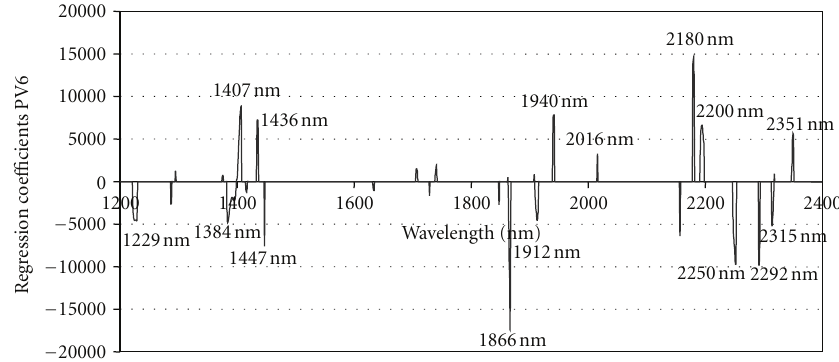
Figure 2: PLS regression coe ffi cients accepted for a generic model (cross-validation data set, 64 samples).